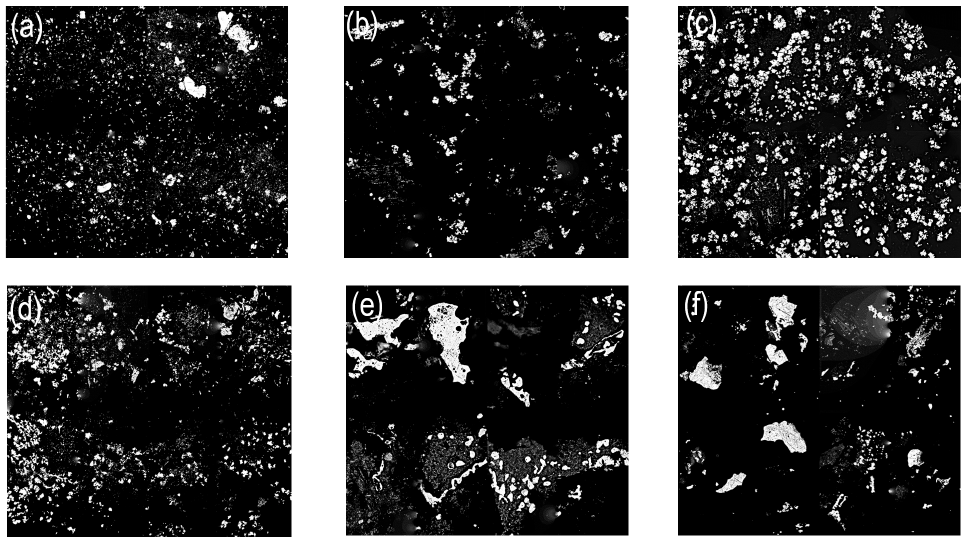
Figure 9. The microstructure of the roasted samples without additives obtained after carbothermic reduction at 1000 °C ( a – c ) and 1200 °C ( d – f ) for 5, 15 and 30 min, respectively (×250 magnification).